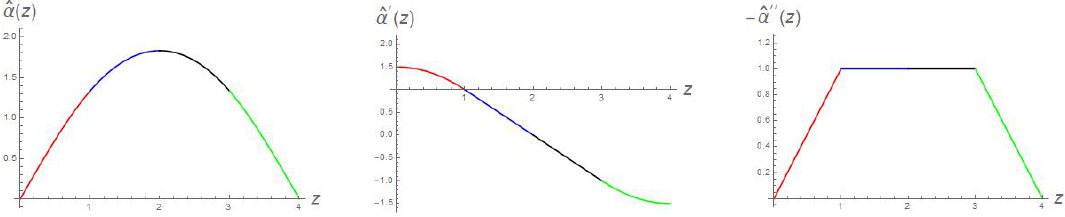
Figure 17. ^ (cid:11) ( z ) and its (cid:12)rst and second derivatives, for the dual background of the quiver in (cid:12)gure